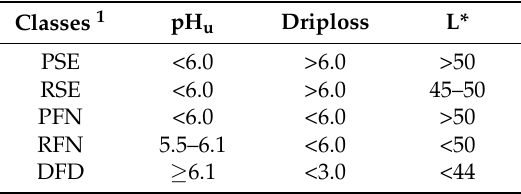
Table 2. Meat quality classification